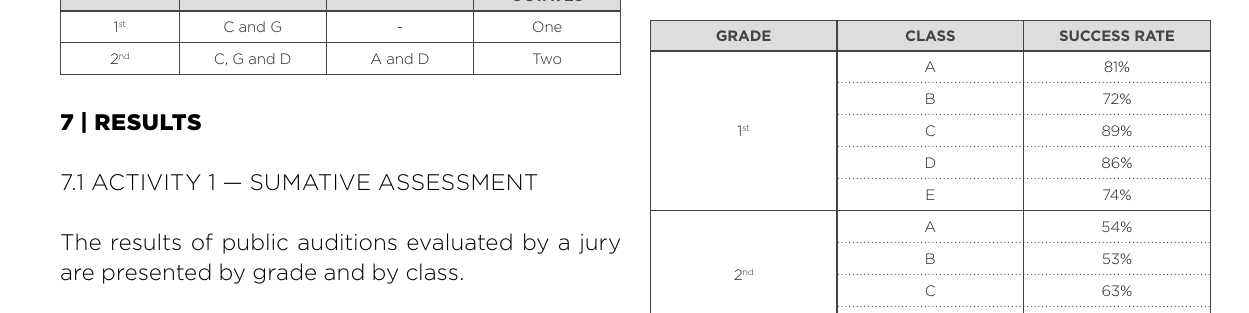
TABLE 6 | Success rate per class in repertoire